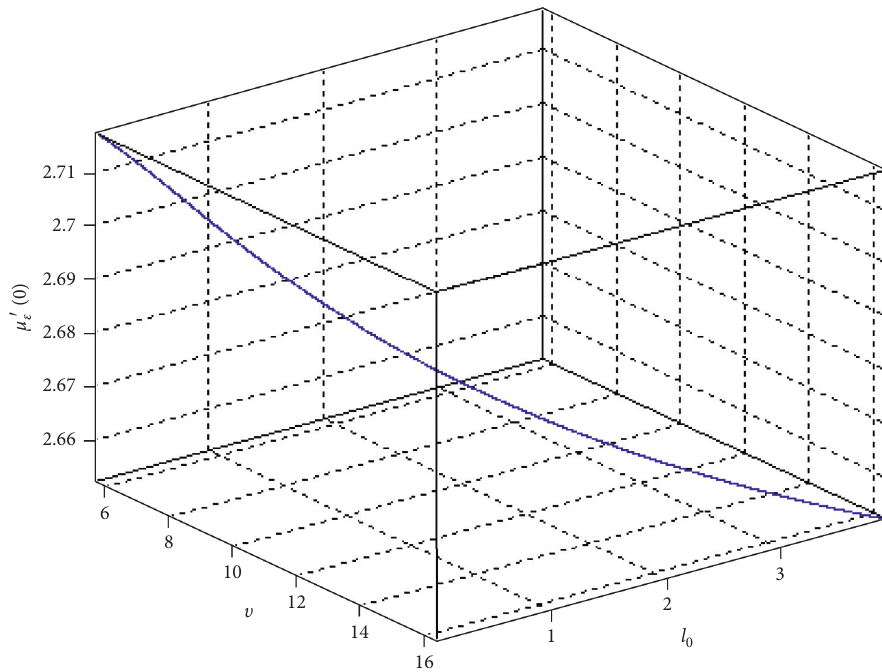
Figure 3: For the system of Figure 2, the curve of μ